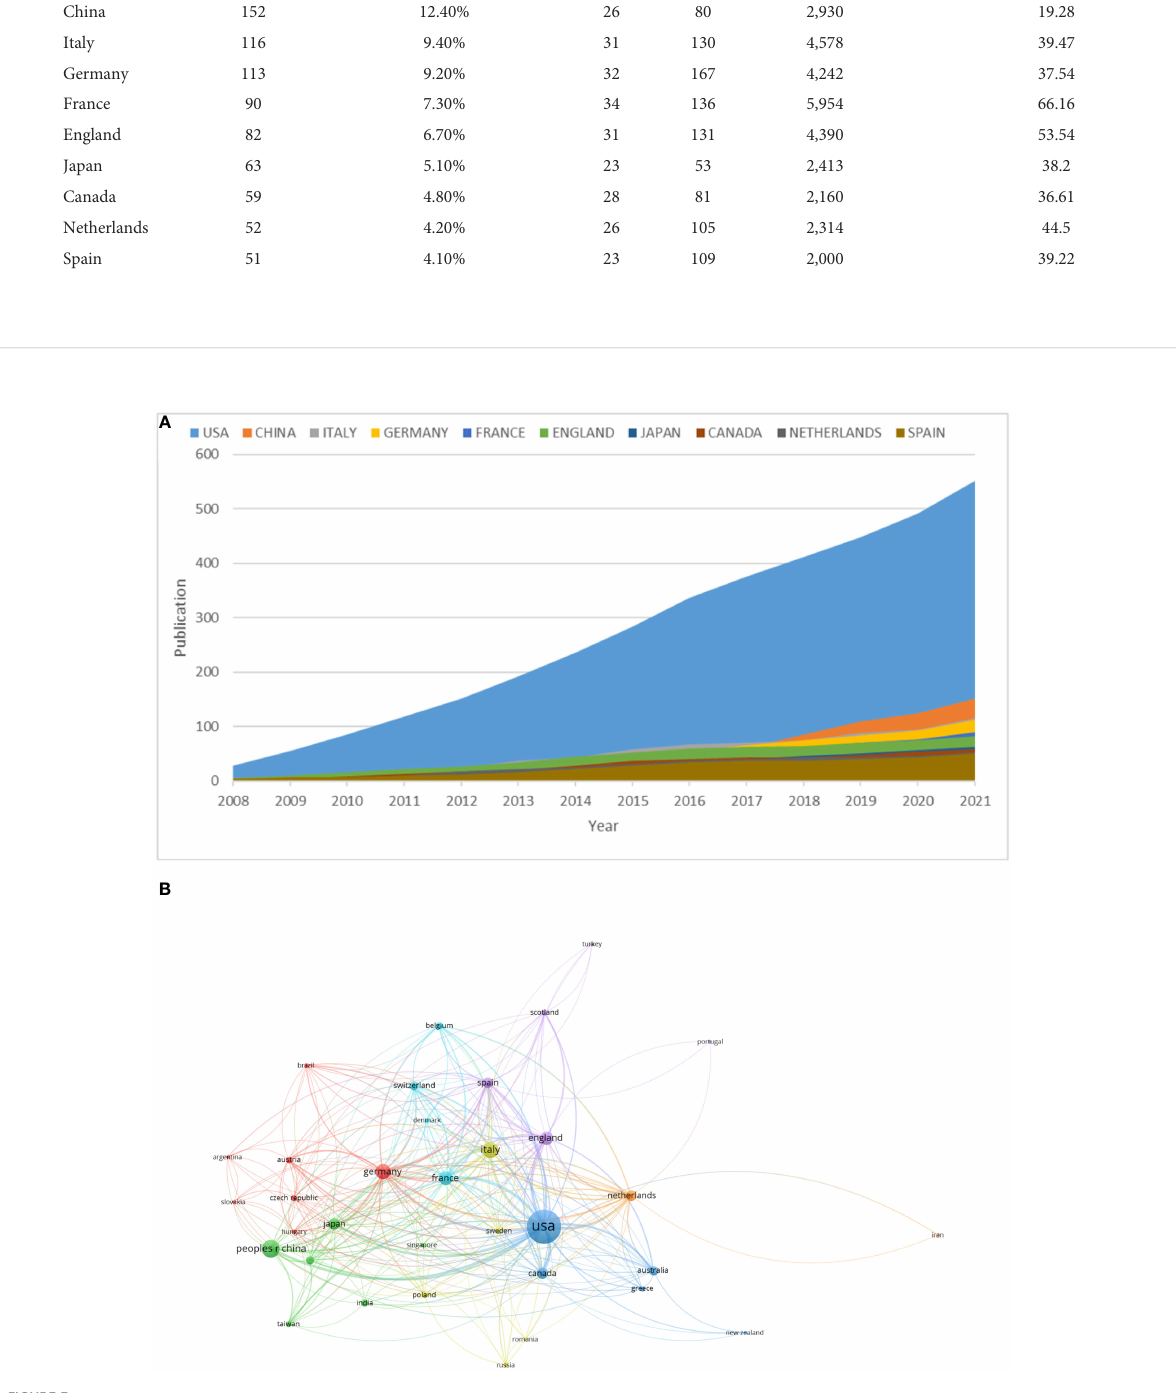
FIGURE 3 (A) The changing trend of the annual publication counts in the top 10 countries. (B) The country citation network visualization map generated by VOS viewer (version5.8 R3). USA, The United States of